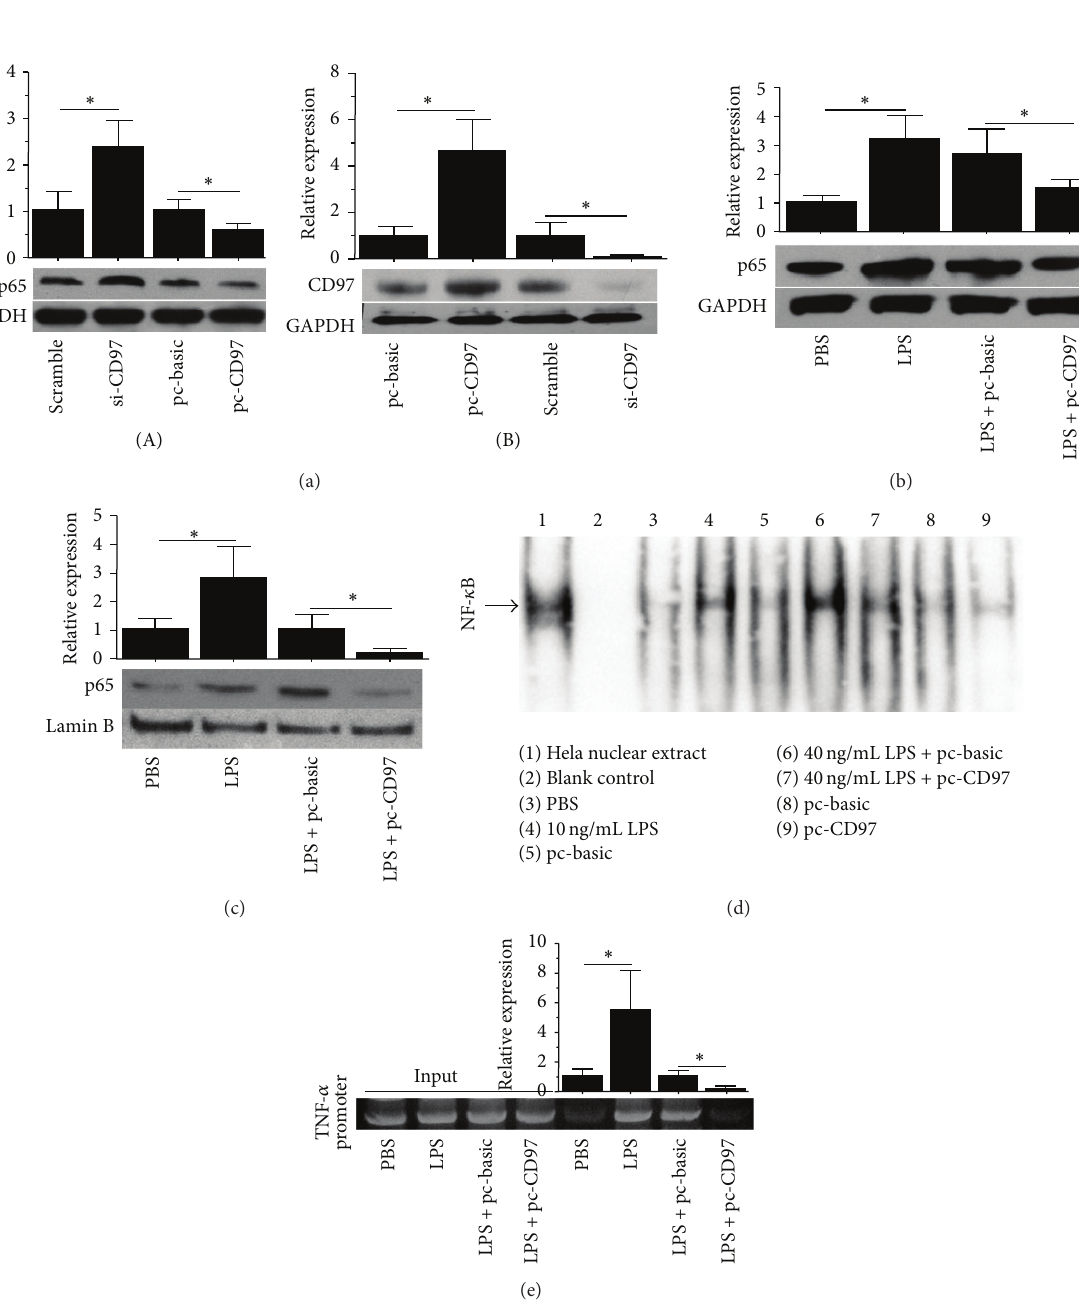
Figure 2: Regulation of LPS induced NF- 𝜅 B activation by CD97 in macrophages. (a) p65 protein level was increased by siRNA mediated CD97 ablation, while p65 expression was inhibited by CD97 ectopic expression (A). CD97 siRNA inhibited CD97 protein level while its ectopic expression increased it (B). (b) CD97 ectopic expression reversed LPS (40ng/mL) induced p65 expression. (c) CD97 ectopic expression reversed LPS (40ng/mL) induced p65 nuclear translocation. (d) Different treatments including LPS concentrations and CD97 overexpression modulated NF- 𝜅 B nuclear activities as analyzed by EMSA. Lane 1: Hela nuclear extract group (positive control). Lane 2: blank control group. Lanes 3 and 4: LPS stimulation promoted NF- 𝜅 B translocation. Lanes 5, 6, and 7: CD97 overexpression inhibited LPS induced NF- 𝜅 B translocation. Lanes 8 and 9: CD97 overexpression inhibited the basal NF- 𝜅 B nuclear level. (e) ChIP assays were performed with LPS stimulation (40 ng/mL) or LPS stimulation and pc-CD97 transfection using antibodies against p65. Chromatin collected before immunoprecipitation served as an input control. The corresponding NF- 𝜅 B responsive elements in the promoter of TNF- 𝛼 gene were amplified and analyzed in later qRT-PCRs ( 𝑝 < 0.05